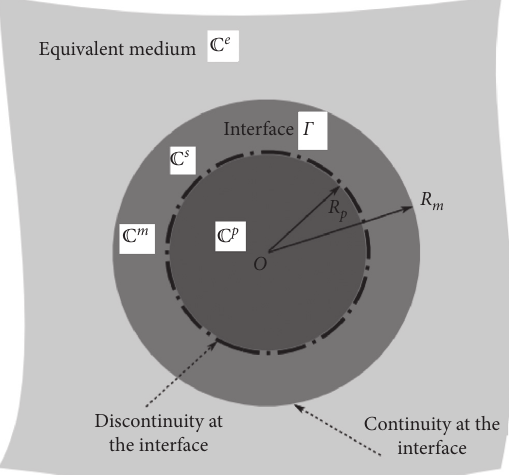
Figure 2: Diagram of generalized self-consistent